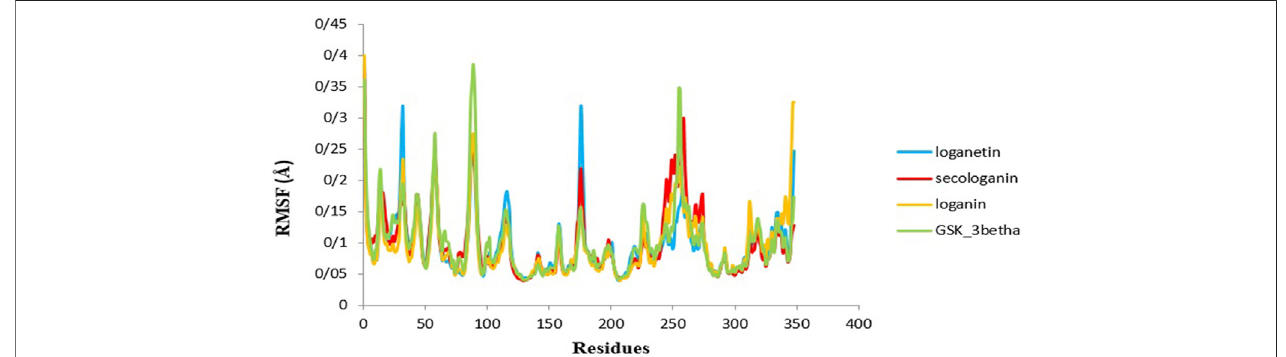
FIGURE9| RMSF analysisGSK3- β protein (green), loganin-GSK3- β complex(yellow), loganetin-GSK3- β complex(blue),and secologanin-GSK3- β complex(red).